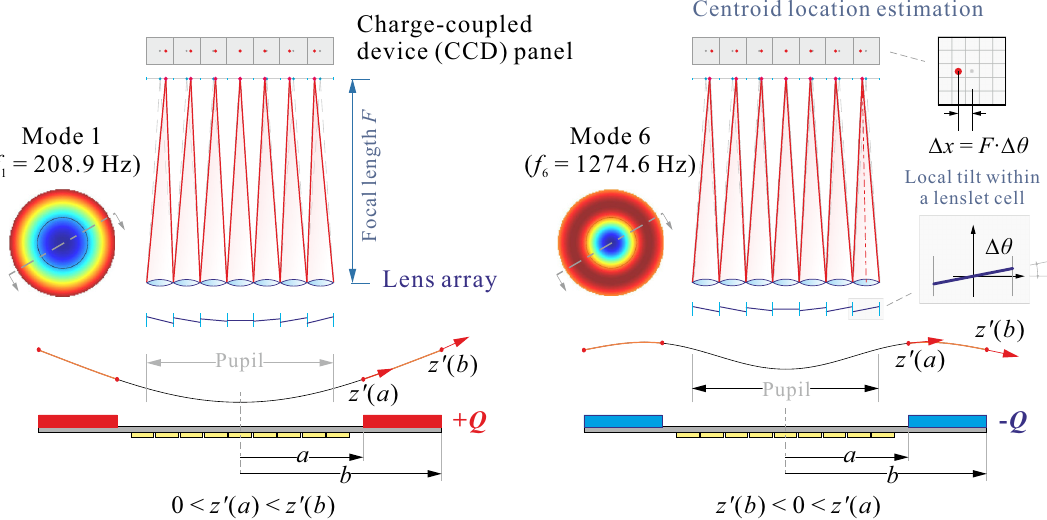
Figure 11. Cross-section in the mirror illustrating the contribution of the piezoelectric sensor for mode 1 and mode 6. The sensor signal is Q = g s [ z (cid:48) ( b ) − z (cid:48) ( a )] and is positive for mode 1 and negative for mode 6. The SH sensor produces similar signals in the central part of the